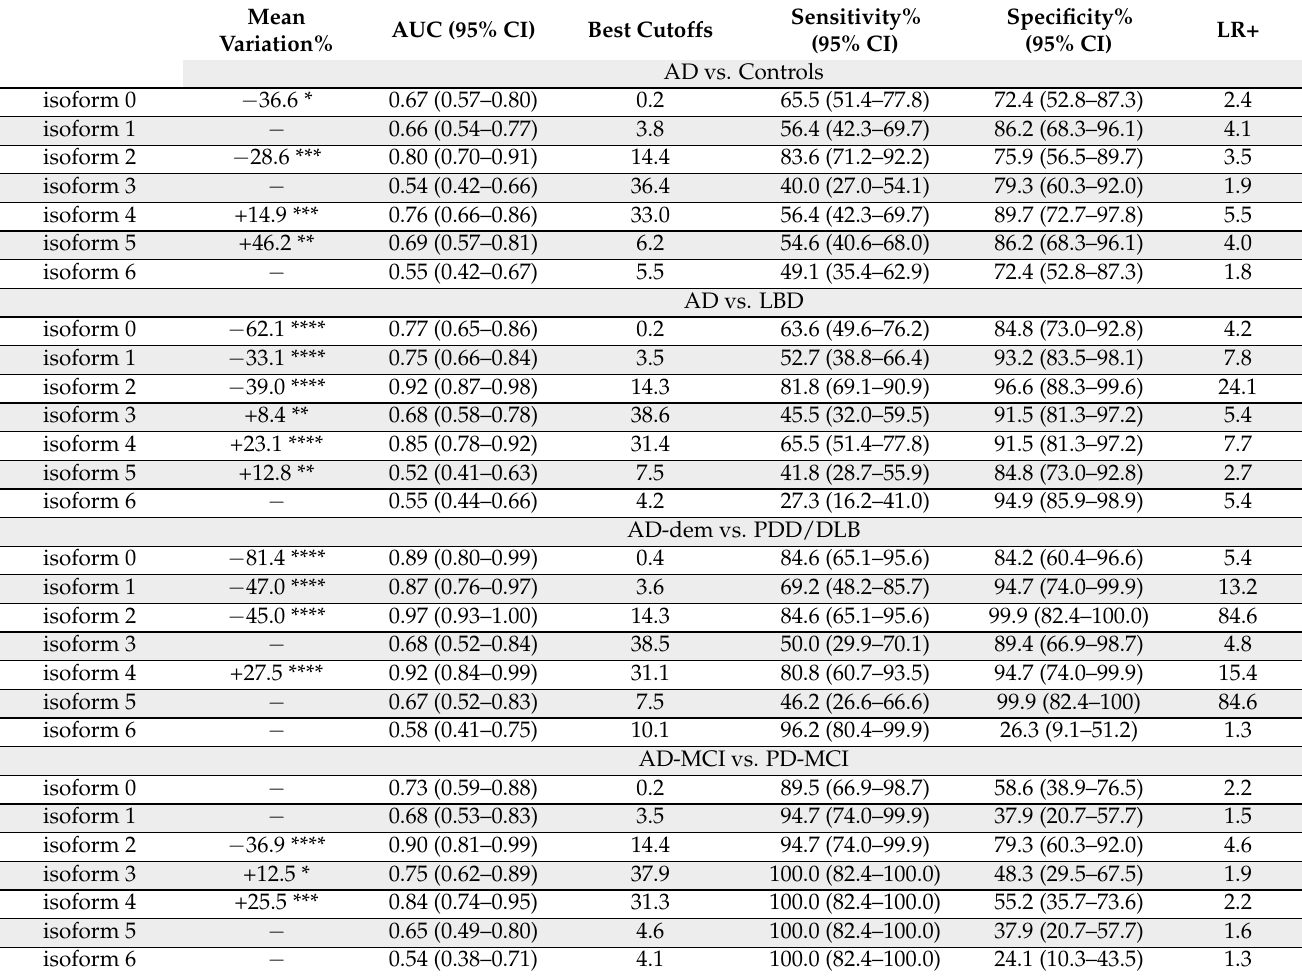
Table 2. Diagnostic accuracy of serpinA1 isoform analysis in Alzheimer’s